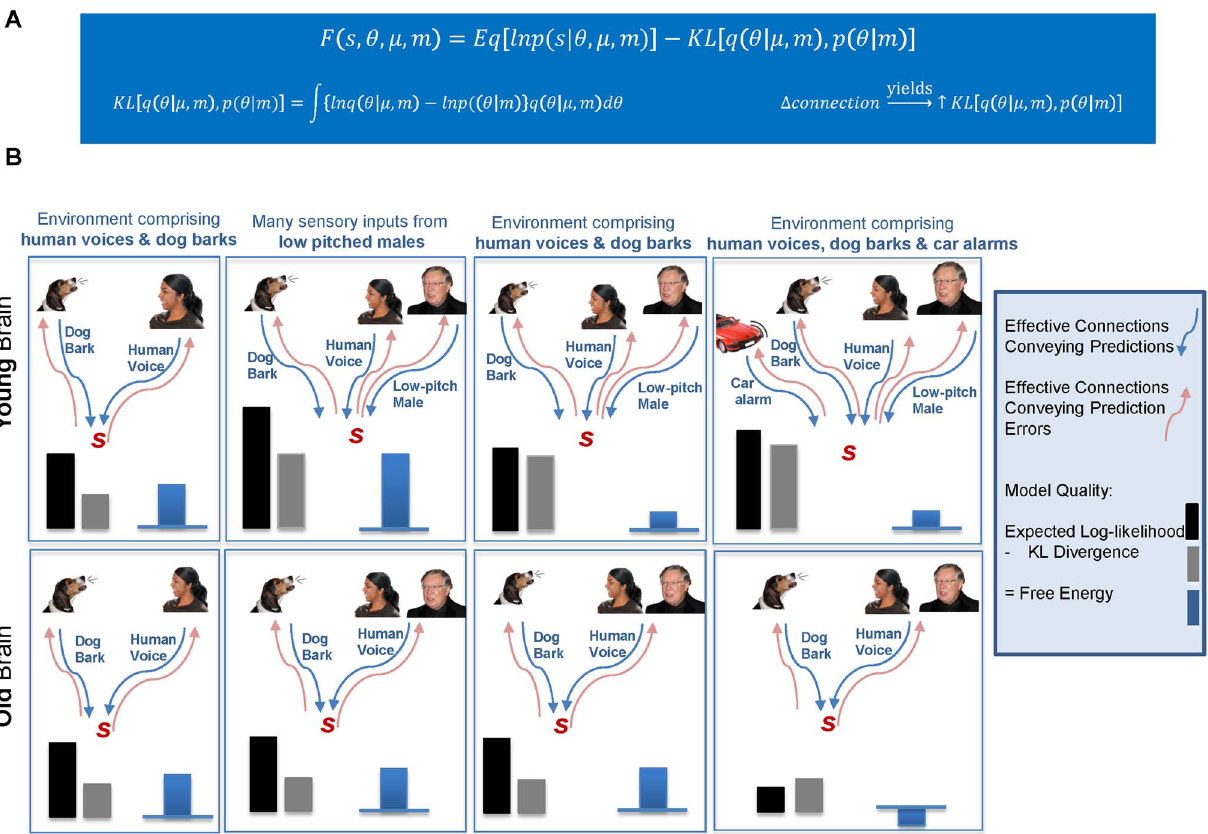
Figure 1. Hypotheses – explanations for sensory input. A) The Negative Free Energy ( F ) is maximized by the brain (model, m ) to ensure homeo/allostasis. An optimal model can accurately predict incoming sensory signals s , (this accuracy term is the expected log-likelihood of the sensory signal s , under the conditional density, q ie. Eq ½ lnp ( s h , m , m ) (cid:2)j ) while ensuring generalization, when inferring new sensory causes ( h represented through their sufficient statistics m ). This complexity penalty ( KL ½ q ( h m , m ), p ( h m ) (cid:2) ) jj is revealed during the presentation of the oddball. Given changes in synaptic efficacy of forward connections; i.e. learning the standard tone - the Kullback-Leibler (KL) divergence between the learned prior, p and the posterior, q under these new (oddball) data will be high. These effects, indicating brittle models, were hypothesized to be less pronounced in older subjects. B) An illustration of how model optimality depends on the environment. Left-most panels: In a constant environment both young (top) and old (bottom) brains have connections that convey accurate predictions (blue arrows). The sensory input, s, will result in prediction error messages (red arrows) that are cancelled by the appropriate prediction. A change in the environment (e.g., from a dog bark to a human voice) will result in prediction error signals along the human voice pathway until human voice predictions are made and cancellation occurs. This type of predictive coding scheme has been proposed as the mechanism underlying the mismatch negativity [17]. In this scenario, both young and old brains generate accurate predictions with similar complexity. Centre Left panels: repeated sensory input from a specific human voice results in new prediction and error pathways for that particular vocalization in a younger brain. For this environment, the younger brain is more accurate (at the penalty of higher complexity) and may outperform the older brain in terms of model quality. Centre Right panels: on return to the original environment, the older brain – that has maintained a less complex model – outperforms the younger brain. Right-most panels: In a